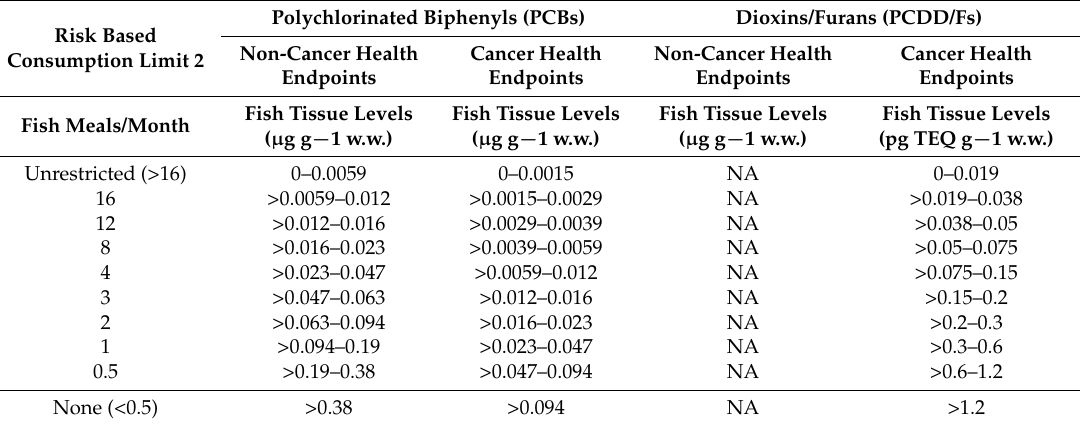
Table 3. The monthly fish consumption limits for carcinogenic and non-carcinogenic health endpoints 1